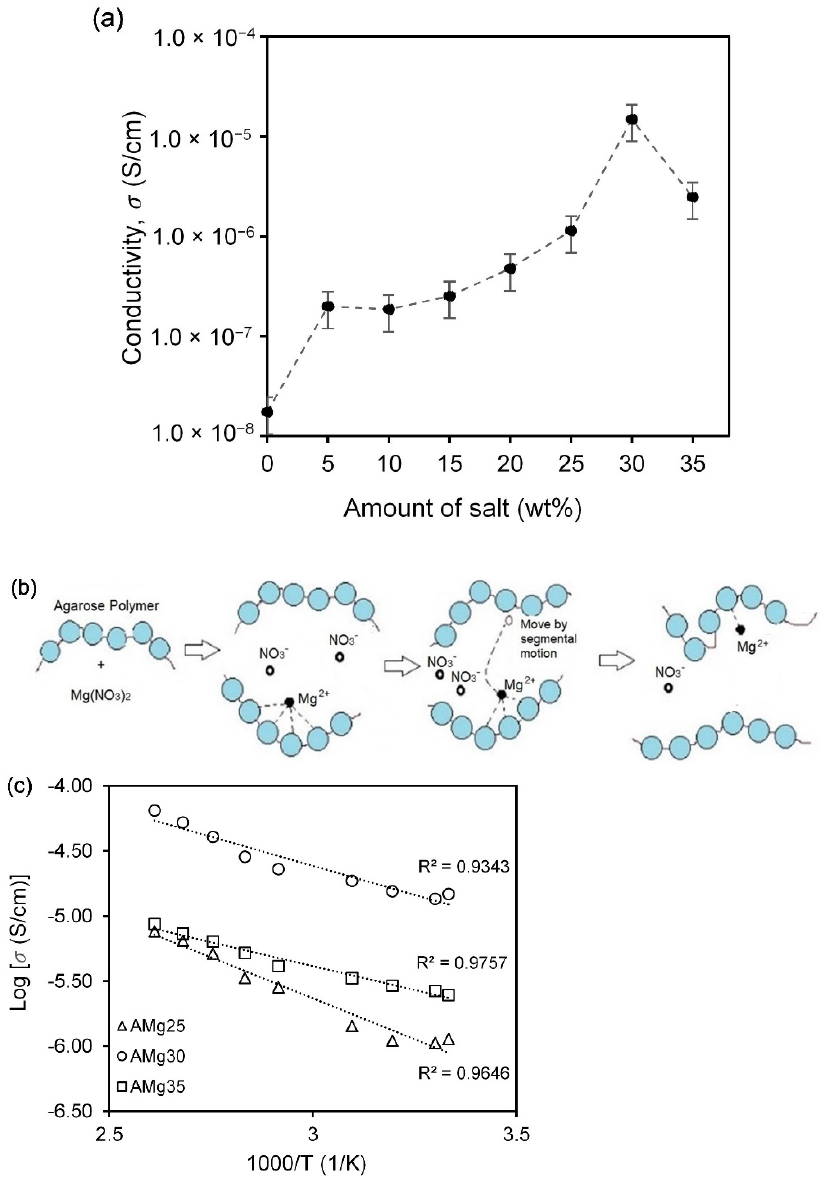
Figure 2. ( a ). Graph of ionic conductivity of agarose-Mg(NO 3 ) 2 in room temperature, ( b ) schematic of segmental motion of Mg 2+ cation into the polymer chain and ( c ) ionic conductivity in various temperatures for the selected composition of agarose ‒ Mg(NO 3 ) 2 polymer electrolyte.